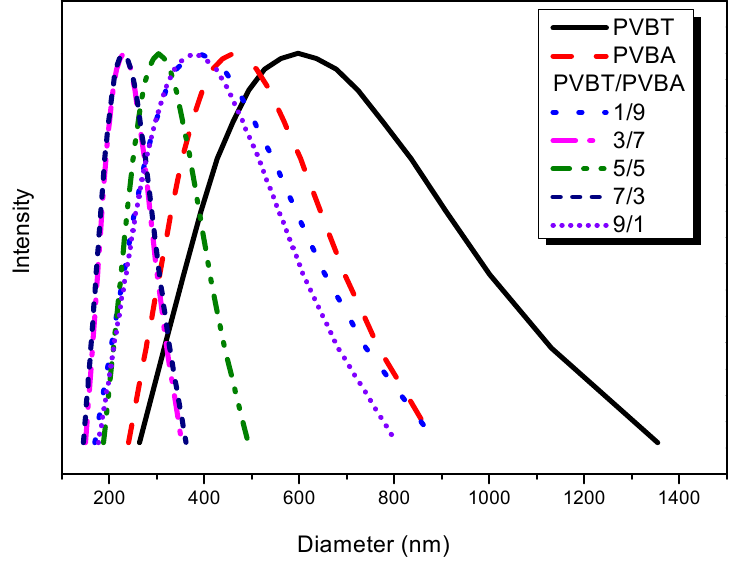
Figure 11. Hydrodynamic radius distributions of PVBT/PVBA blend complexes of various compositions.